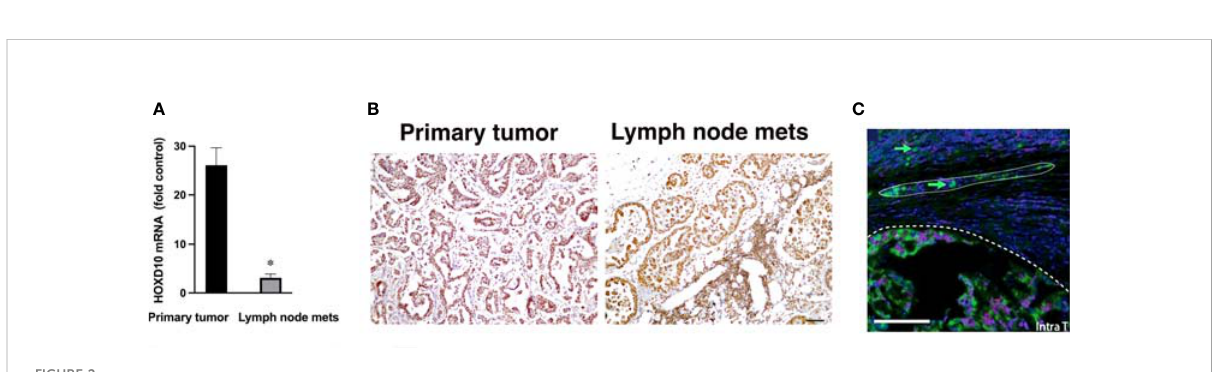
FIGURE 2 Expression of the direct miR-10b target, HOXD10, in patients with FMC. (A) qRT-PCR analysis of HOXD10 expression in primary tumors and lymph node metastases in spontaneous mammary carcinoma in cats. Data from cats 0, 1, 8, 9 and 7 are shown. HOXD10 expression was signi fi cantly higher in the primary tumors than in the metastases (n = 3, p < 0.01). Data are represented as mean ± s.d. (B) Representative staining for HOXD10, a direct miR-10b target, demonstrating strong signal in the primary tumor (left) and a lower signal in lymph node metastases (right). Scale bar = 100µm. (C) Representative ISH fi eld of a primary breast tumor showing miR-10b expression at the invasive front ( — ) and detached invading cancer cells (arrow) migrating as a group ( … .) and individually. Scale bar =